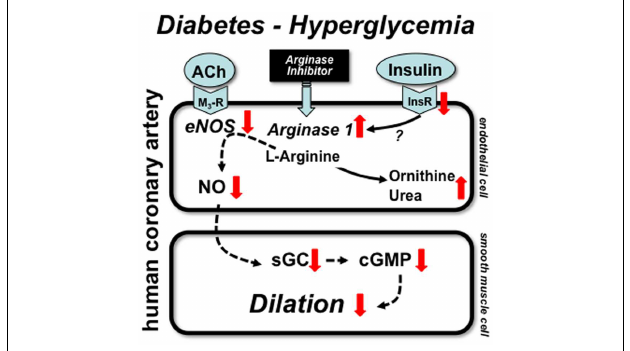
FIGURE 1 | Mechanisms of coronary artery dysfunction in diabetes . Schematic draw demonstrates proposed mechanisms by which diabetes and hyperglycemia lead to up-regulation of arginase-1 resulting in reduced NO-mediated dilation in human coronary arteries. Alterations in insulin signaling may contribute to arginase up-regulation, which reduces the level of l-arginine and thereby limit NO synthesis. ACh: acetylcholine, M 3 -R: M 3 muscarinic receptor, InsR: insulin receptor, sGC: soluble guanylate cyclase, cGMP: cyclic guanosine